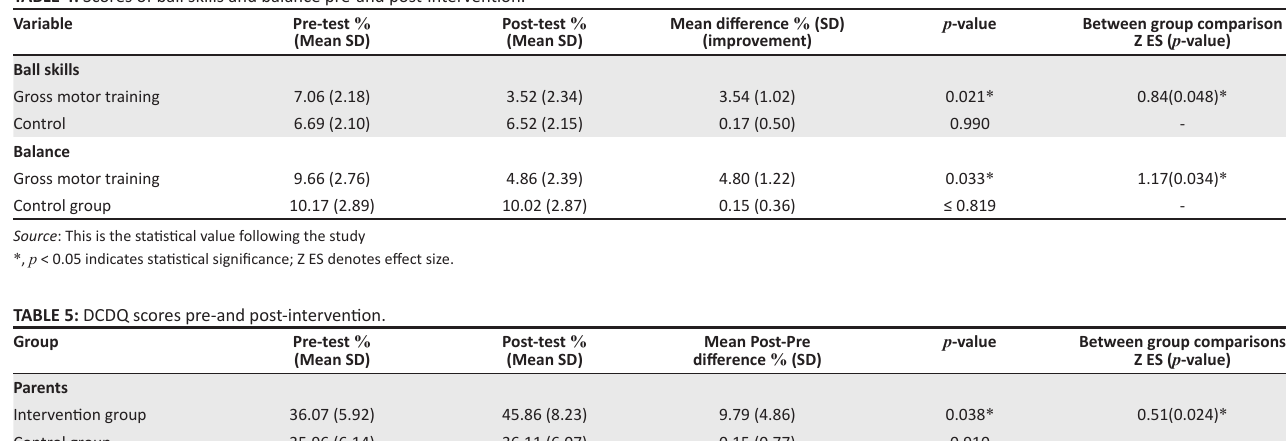
TABLE 4: Scores of ball skills and balance pre-and post-intervention. Variable Between group comparison Ball skills